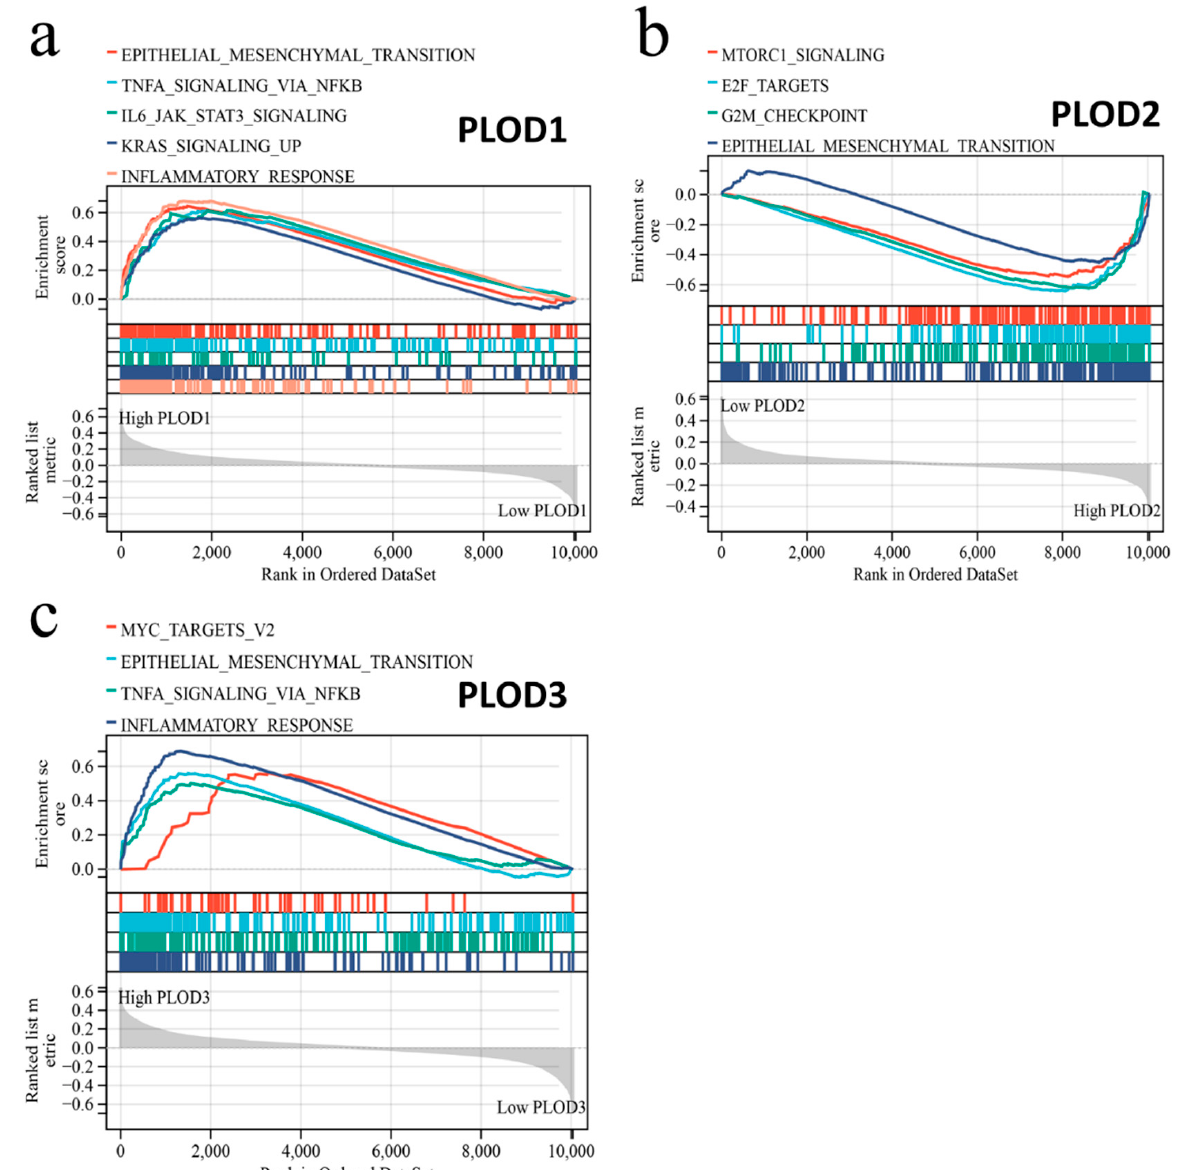
Figure 8. Gene set enrichment analysis of PLOD family members. The relation of PLODs to biological processes and signal transduction pathways using the HALLMARK gene set. ( a ) PLOD1, ( b ) PLOD2, and ( c ) PLOD3.